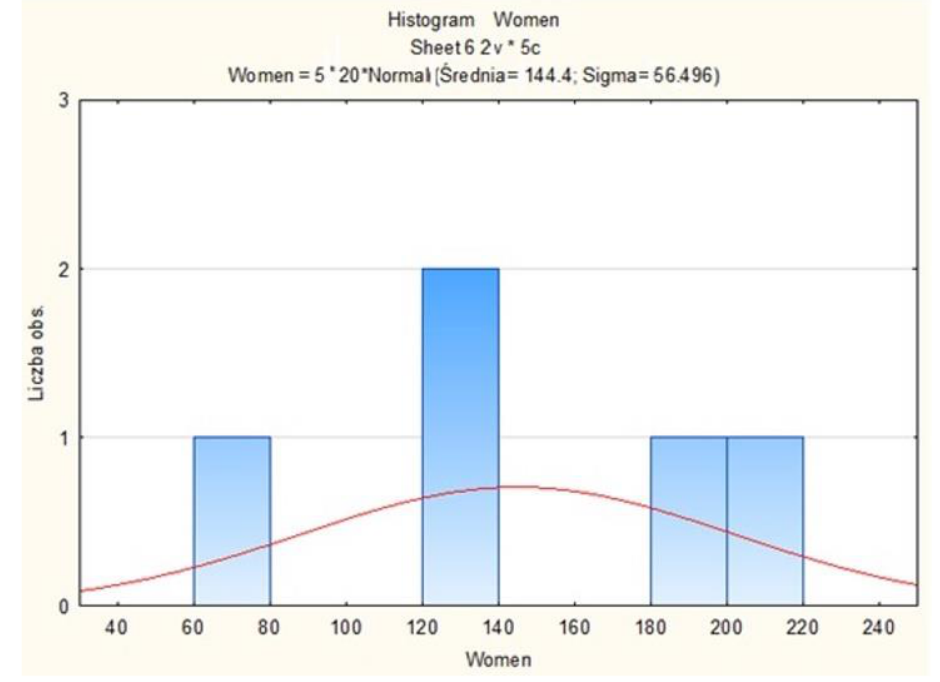
Figure 16. Structure of employees by women.